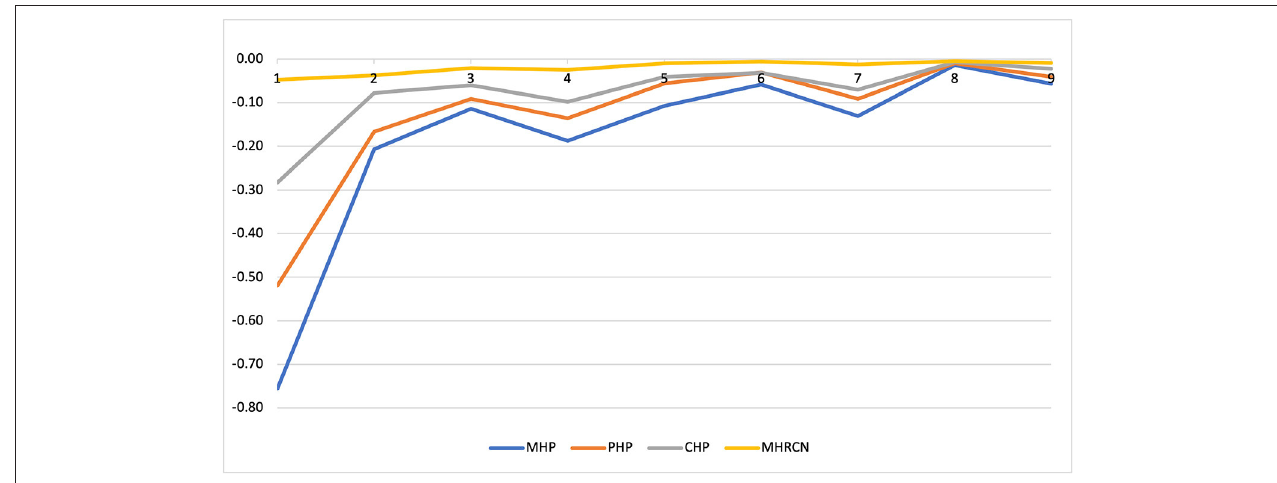
FIGURE 2 | Additional information by